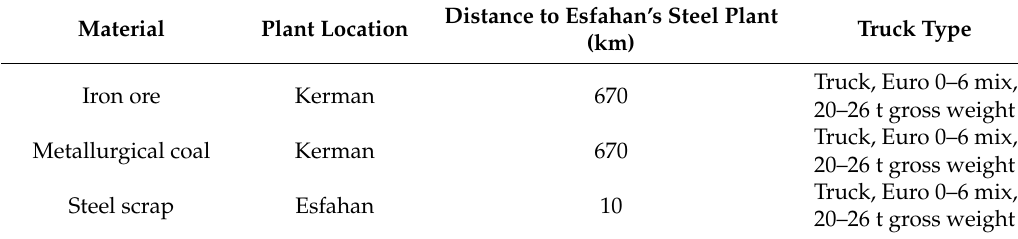
Table 4. Transportation of steel-BOM.